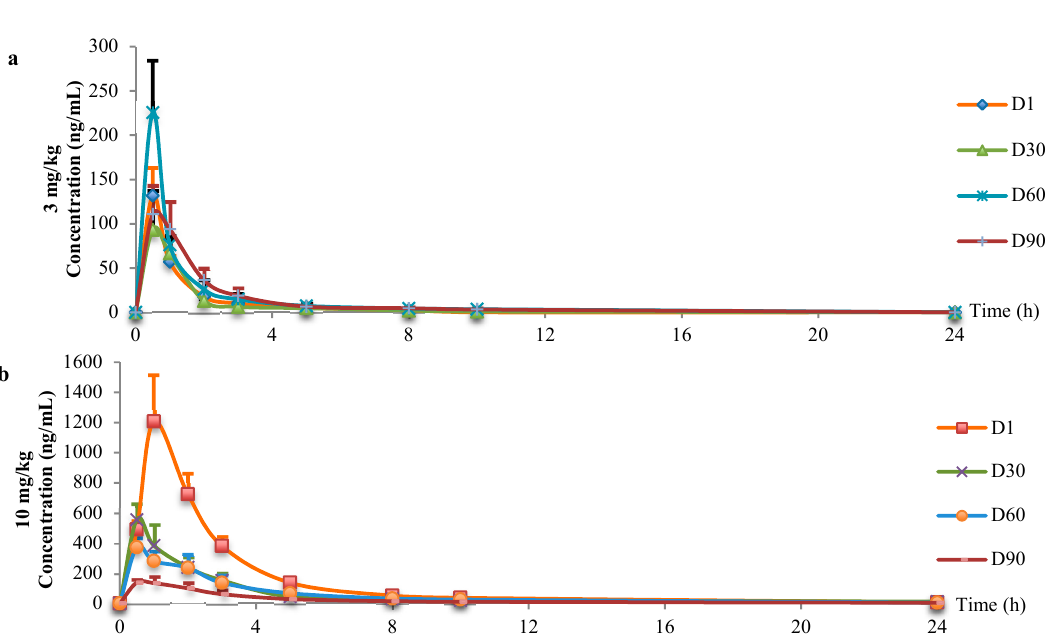
Figure 2. Mean plasma concentration-time profiles. (a) 3 mg/kg. (b) 10 mg/kg.